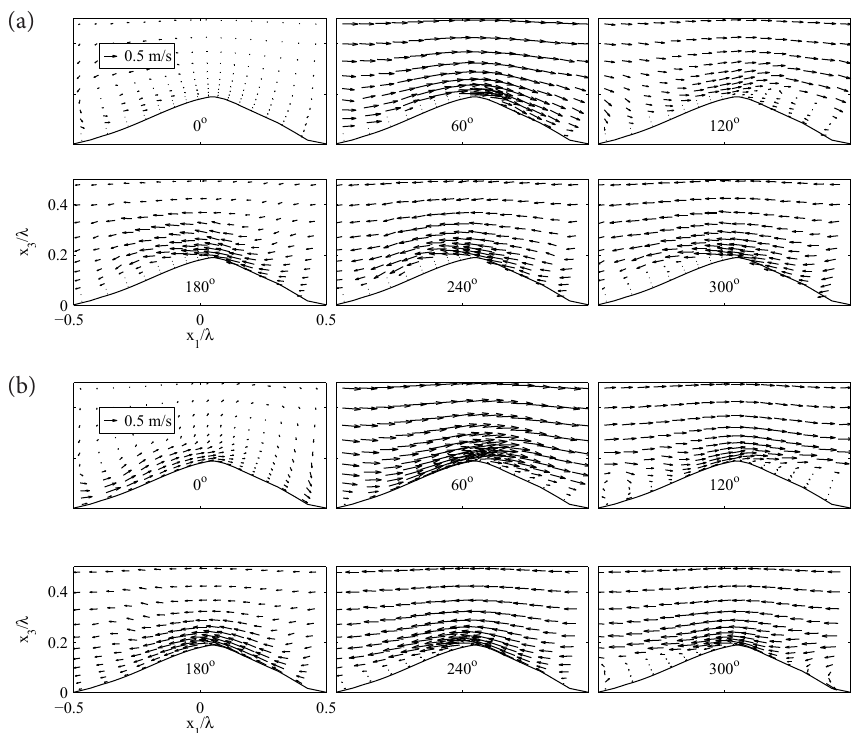
Figure 5. Flow velocity field, for phase ωt = 0, 60, 120, 180, 240, 300 ◦ . (a) Measured by PIV in suspended sand (not corrected for settling velocity) in the Mr5b63 experiment of van der Werf et al. (2007). Measurements are interpolated onto the LES computational grid (for consistency), and plotted every other point (for clarity). (b) LES computations of same experiment assuming a surface roughness of z 0 = d 50 / 4.